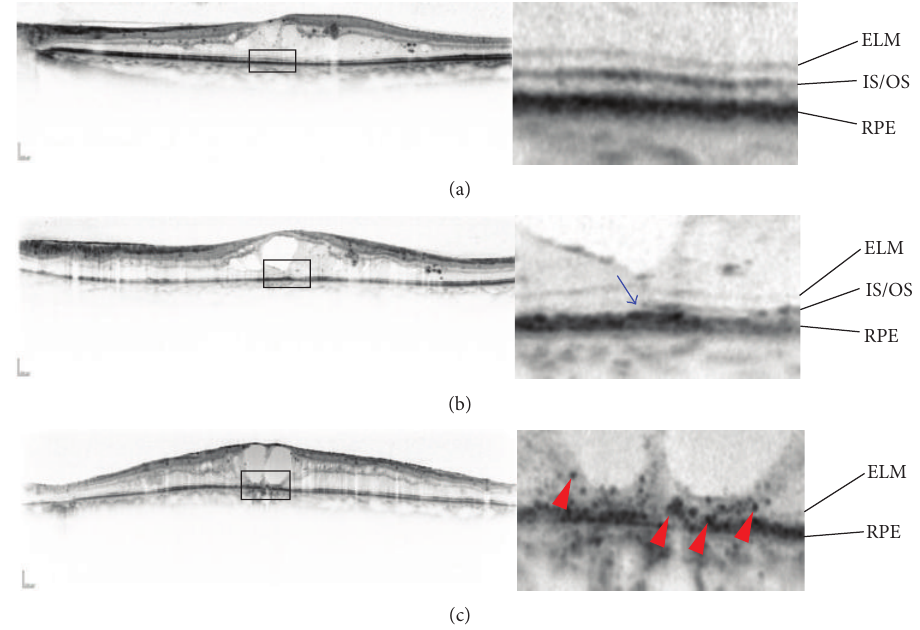
Figure 6: Pathological changes in the photoreceptor layers in DME. (a) Both the ELM and IS/OS lines are continuous. (b) The ELM line seems almost continuous, whereas the IS/OS line is discontinuous on the left (arrow). (c) The ELM line is disrupted, and the IS/OS line is absent at the fovea, accompanied by hyperreflective foci in the outer retinal layers